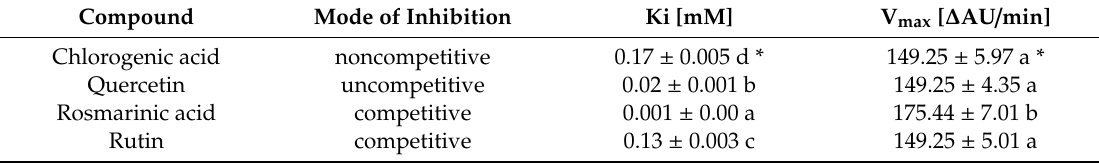
Table 4. Mode of inhibition, K i and V max values of chosen polyphenols on TPO activity, n =